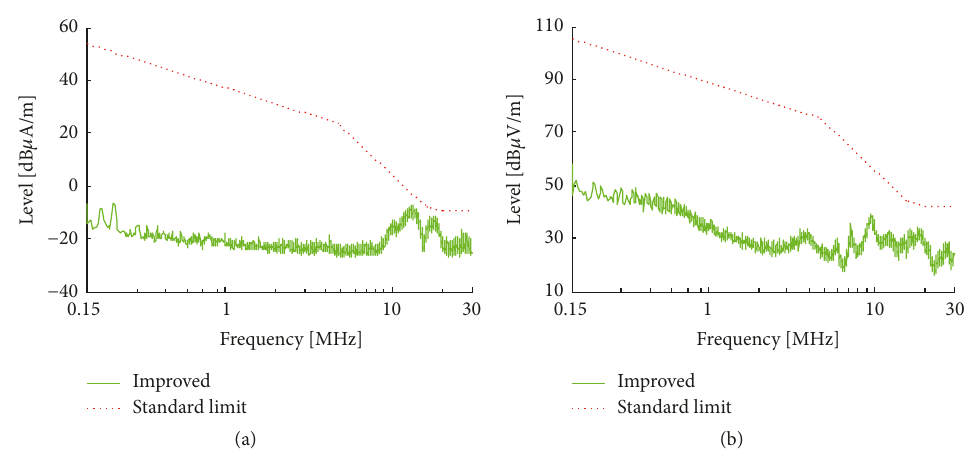
Figure 10: Test result after improvement: (a) magnetic field; (b) electric